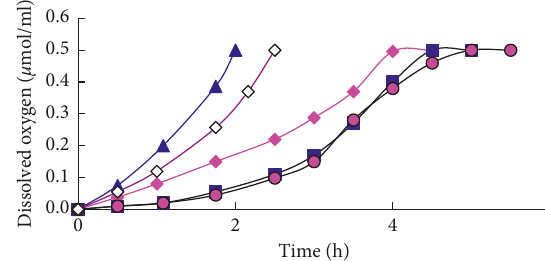
Figure 4: Effect of β -CD concentrations on dissolved oxygen in distilled water. Solid line with “ 0.02% β -CD; solid line with “ is 0.1% β -CD; solid line with “ • ” is 0.5% β